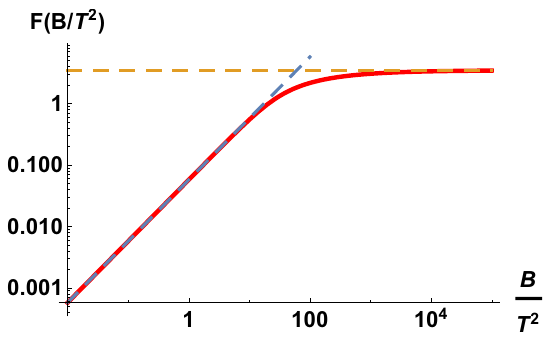
(cid:0) B (cid:1) Figure 2 . Hall viscosity ( (cid:17) (cid:24) F B ) at zero chemical potential as a function of B=T 2 (red T 2 H continuous line). Dashed lines show the asymptotic power laws. In particular blue dashed line corresponds to F = 9 B , on the other hand orange dashed line corresponds with the (cid:12)tting p 16 (cid:25) 2 T 2 F = 2